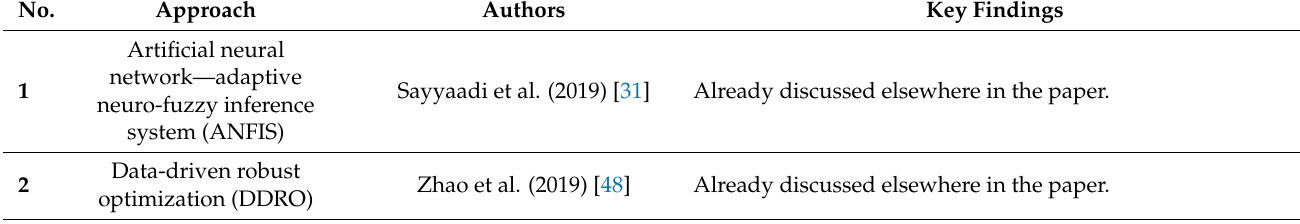
Table 4. Optimization methods used in energy efficiency case